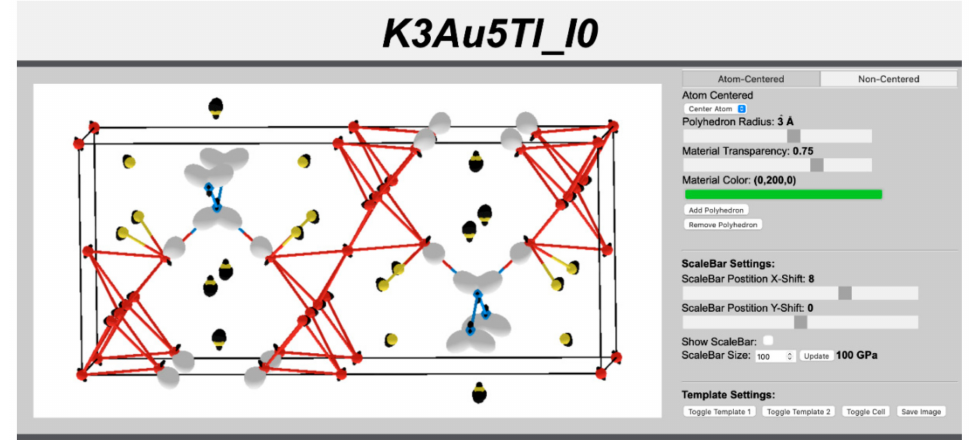
Figure 6. The addition of a unit cell to the FigureToolWeb plot of K 3 Au 5 Tl.